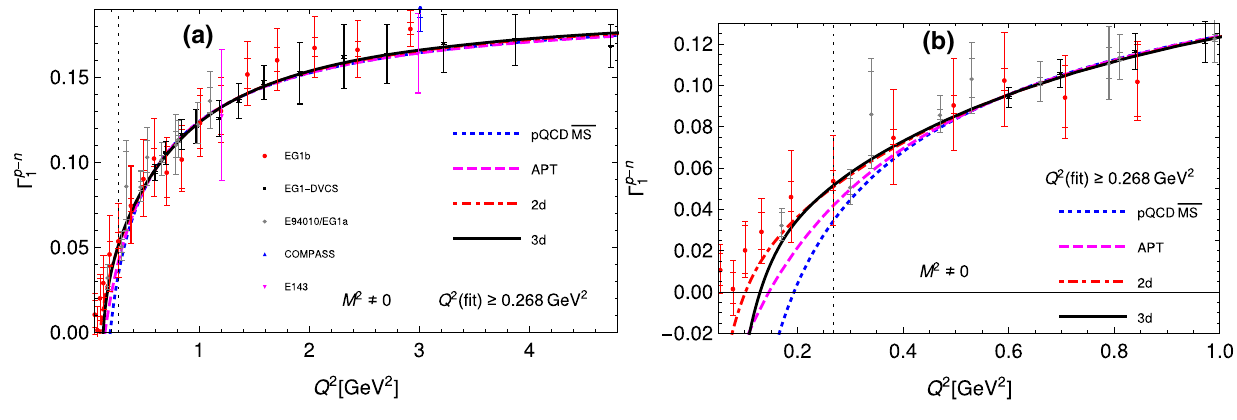
Fig. 5 As Fig. 3, but for the fit the OPE expression (16) with “massive” higher-twist term was used Table 3 As in Table 2, but now the OPE form is “massive”, Eq. (16). The fits were made only for Q 2 of the squared mass M 2 are in GeV